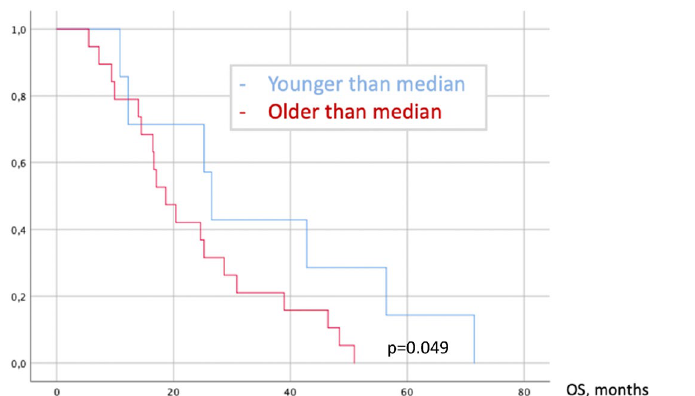
Figure 2. Achieved OS in relation to